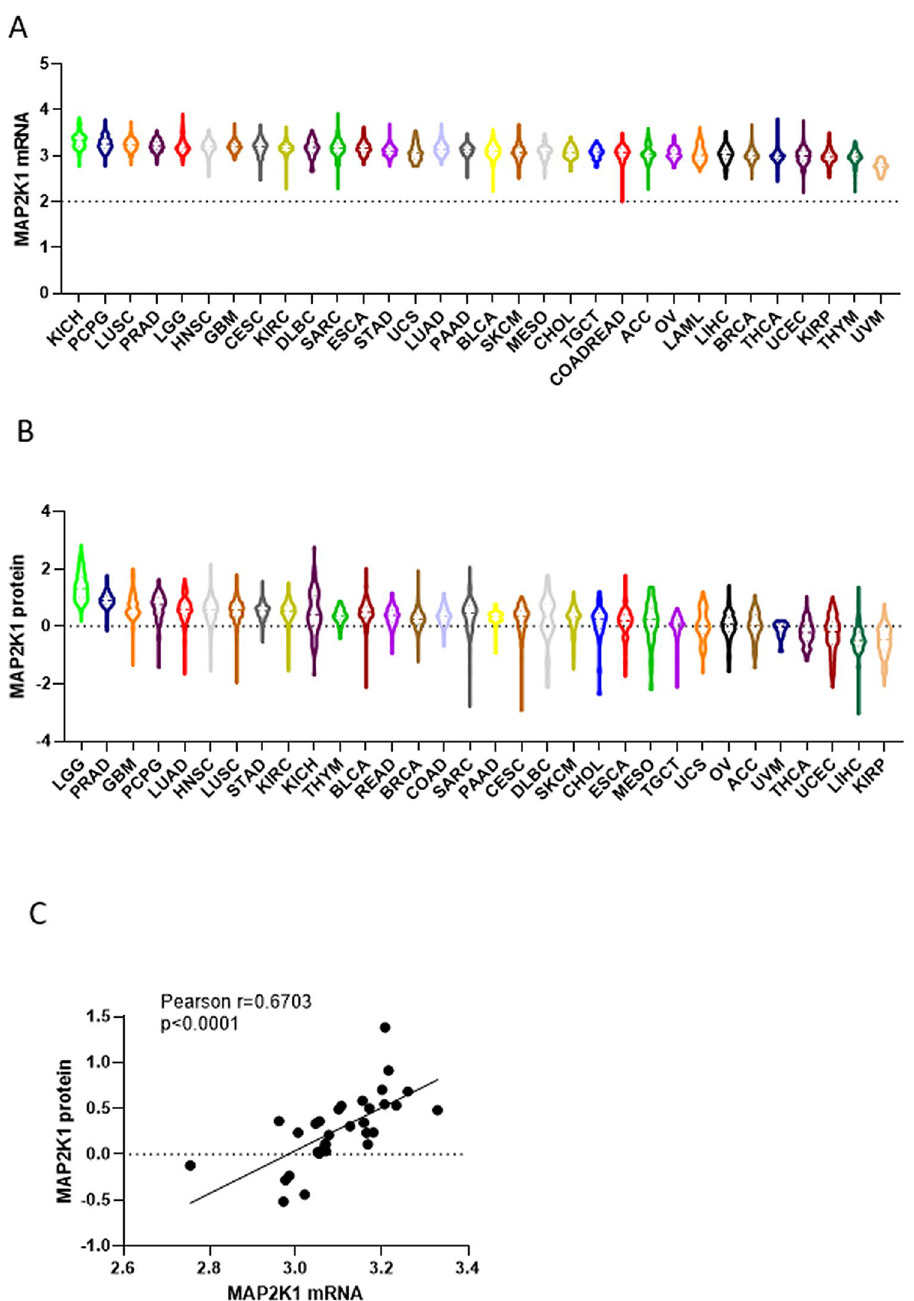
Figure 1. The expression of MEK1 mRNA and protein from The Cancer Genome Atlas (TCGA). ( A ) MEK1 mRNA expression in pancancer. ( B ) MEK1 protein expression in pancancer. ( C ) MEK1 mRNA expression had a positive correlation with MEK1 protein expression across 32 types of cancer